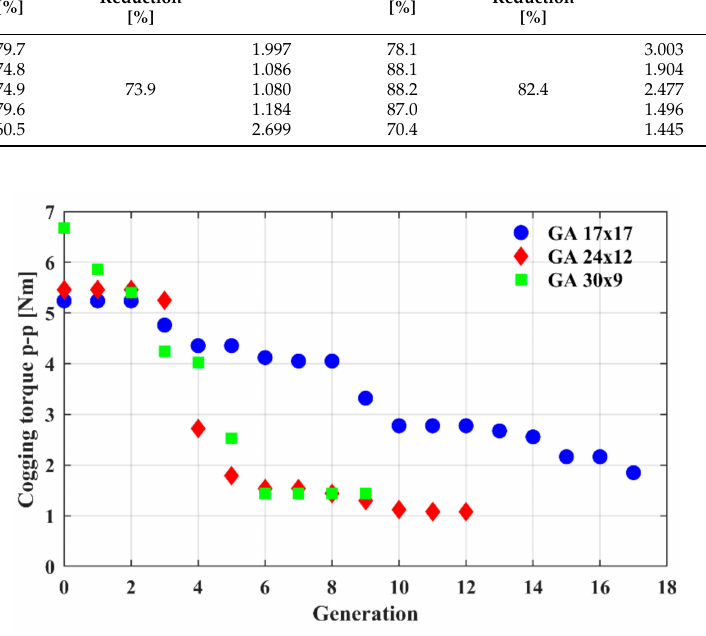
Figure 13. Best individuals evolution among GA generations obtained with the direct